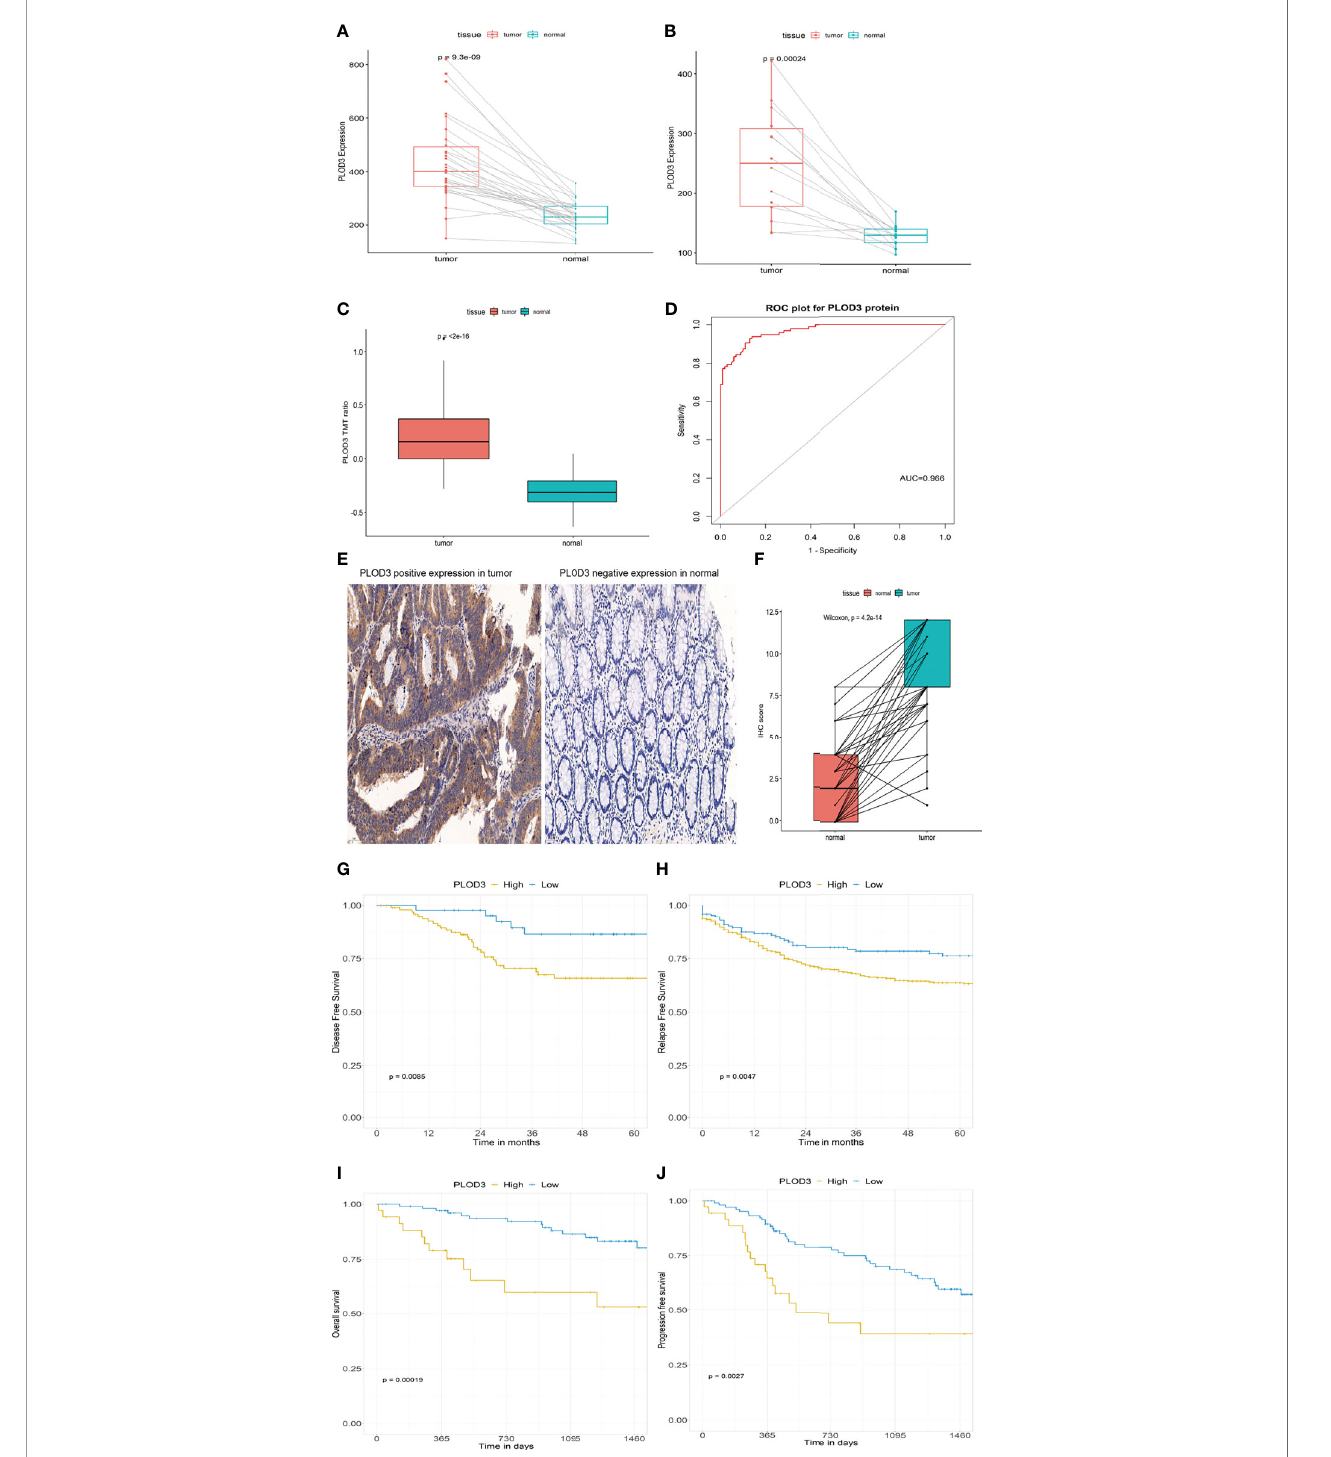
FIGURE 6 | PLOD3 expression in CRC and normal tissues from the GSE74602 (A) and GSE113513 (B) cohorts; PLOD3 protein expression difference in CRC and normal tissues and TMT ratio means the protein abundance by TMT-based quantitation (C) and ROC curve of PLOD3 protein for discriminating tumor and normal tissues in proteome dataset (D) ; (E) Representative microphotographs of PLOD3 immunohistochemical staining in CRC tissue and adjacent normal tissue by IHC. Scale bar = 50 m m. (F) IHC scores in CRC tissues and adjacent tissues. Prognostic value of PLOD3 in the GSE17536 (G) and GSE39582 (H) cohorts; Prognostic value of PLOD3 in the proteome dataset (I, J)